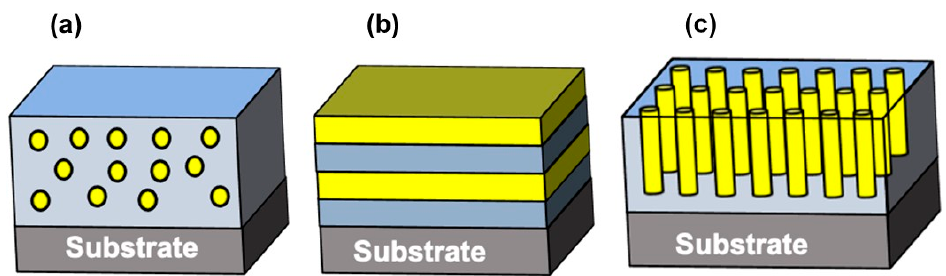
Figure 2. Schematic of ( a ) 0-3, ( b ) 2-2, and ( c ) 1-3 composite nanostructures.